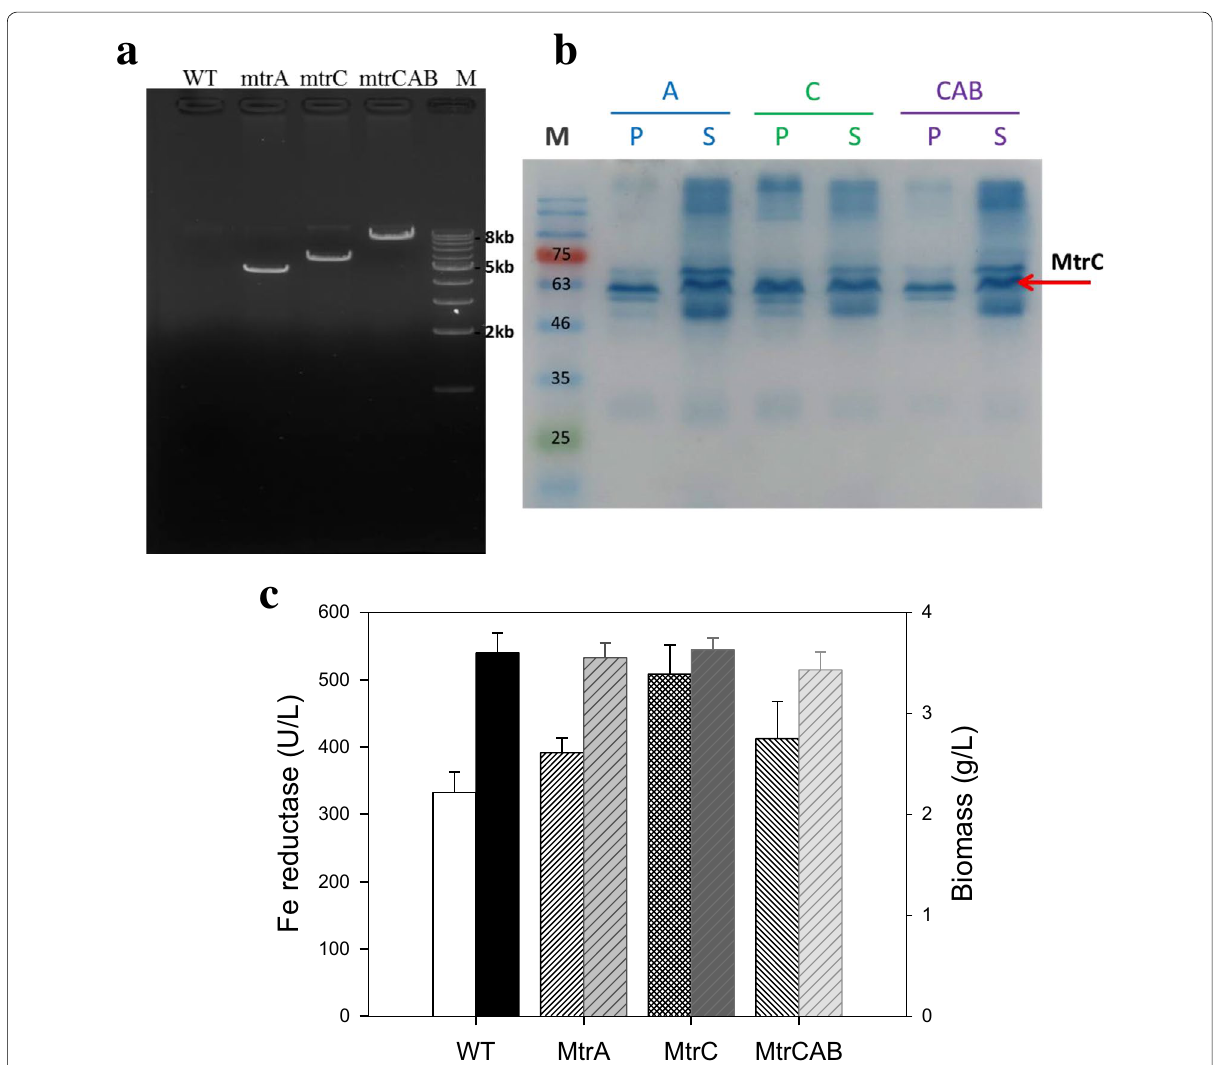
Fig. 3 a Confirmation of plasmids in wild type of MR1, mtr A , mtr C and mtr CAB by 0.8% agarose gel. b Heme staining activity of cells harboring of mtr A , mtr C and mtr CAB genes. Cell harvest at 24 h and concentrated to OD 4. P and S mean pellet and supernatant. c Left bars are ferric reductase activity and right bars are biomass of wild type of MR1, mtr A , mtr CAB and mtr C